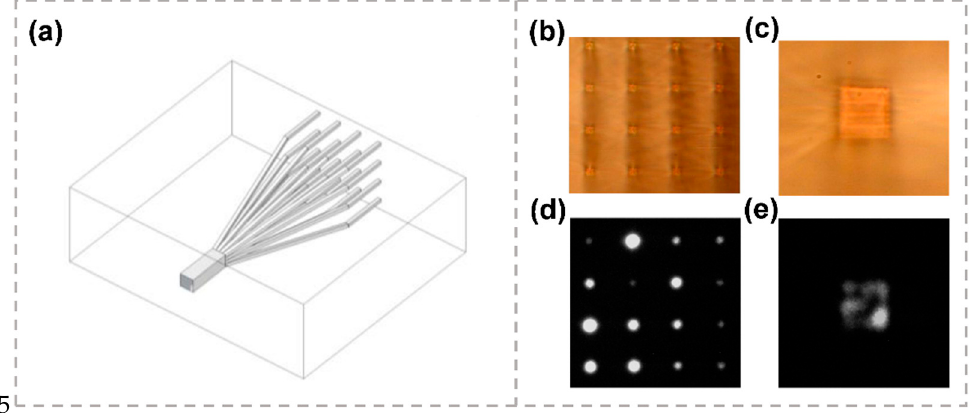
Figure 11. ( a ) Three-dimensional schematic of photonic lantern structure. ( b ) Microscope image of the 4 × 4 single mode array output facet of the photonic lantern. ( c ) Microscope image of the multi-mode waveguide output facet of the photonic lantern. ( d ) Nearfield profiles at the single mode array waveguide output produced by injecting 1550 nm light into the multi-mode inputs. ( d ) Nearfield profiles at the multi-mode waveguide output produced by injecting 1550 nm light into the opposite end [120]. Reproduced from [120] with permission of the Optica Publishing Group, 2022.